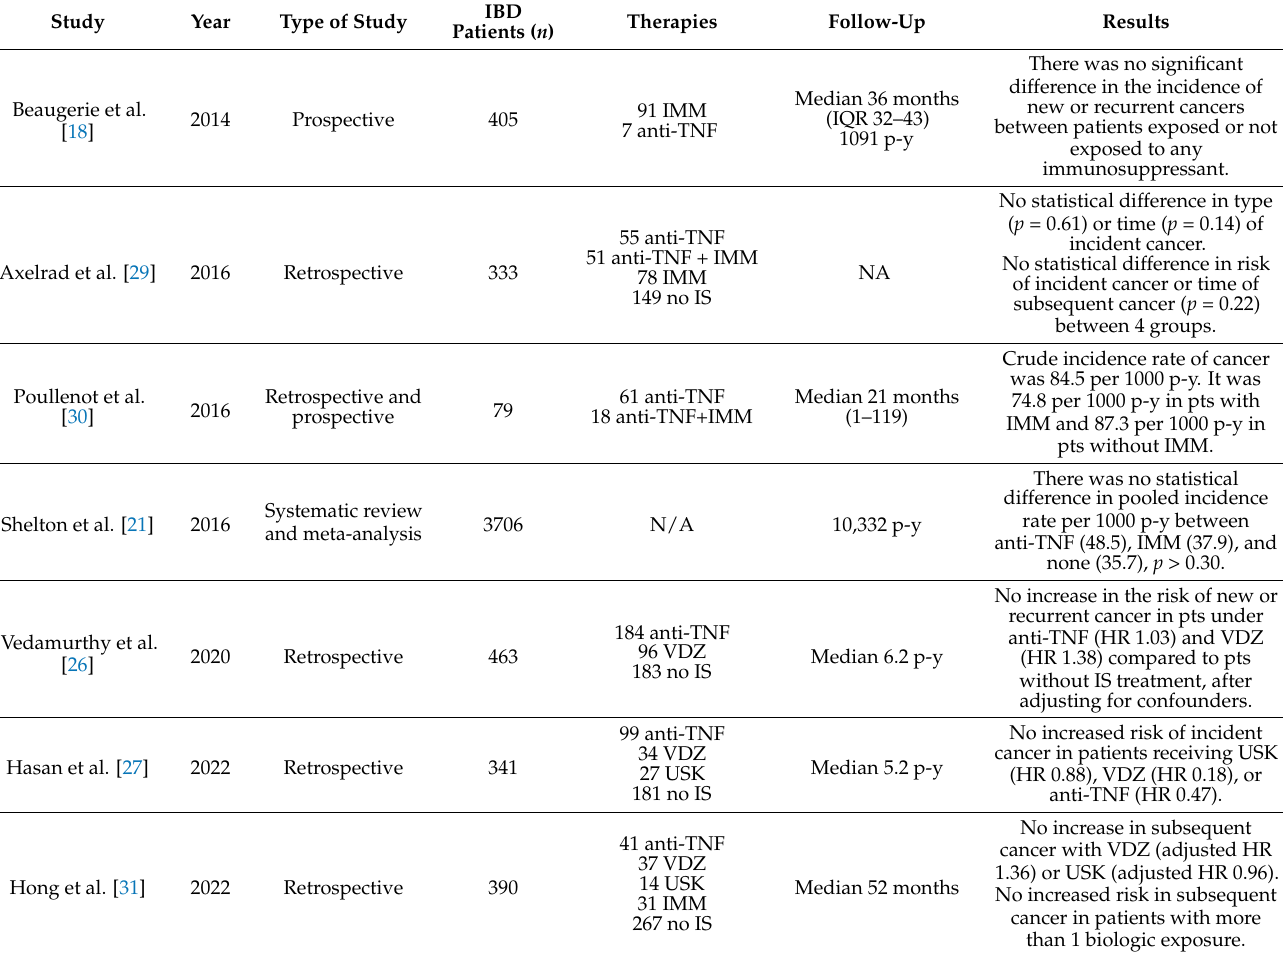
Table 1. Studies on IBD patients with previous diagnosis of cancer under immunomodulators or biologic